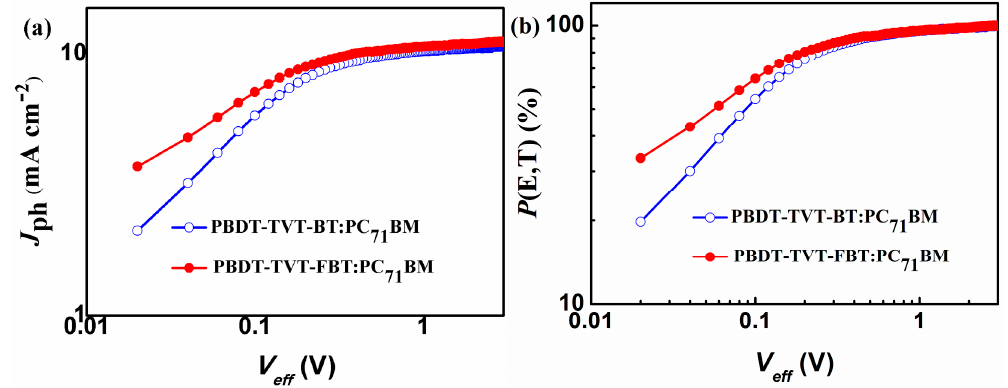
Figure 8. J ph versus V eff ( a ) and P (E,T) ( b ) versus V eff curves for the optimized PBDT-TV-BT:PC 71 BM and PBDT-TVT-FBT:PC 71 BM-based devices.